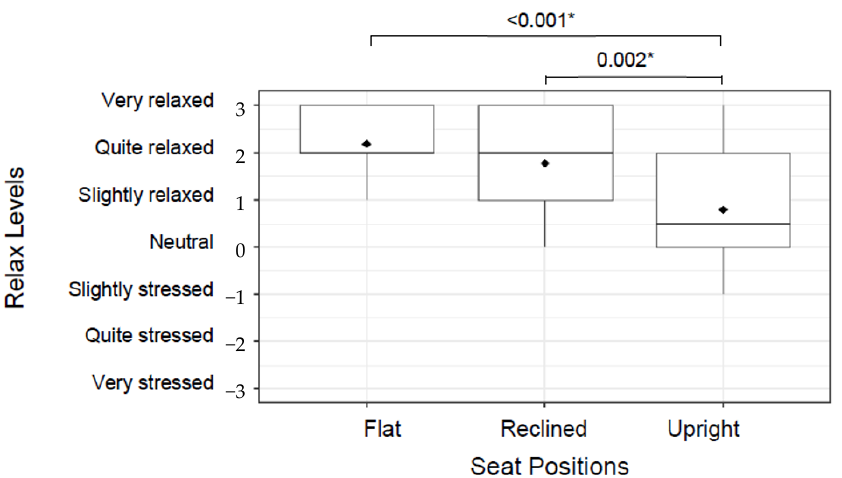
Figure 8. Relax levels from the question “How relaxed did you feel while experiencing the seat?” * symbol indicates a significant effect ( p < 0.05). The diamond shapes indicate the mean.